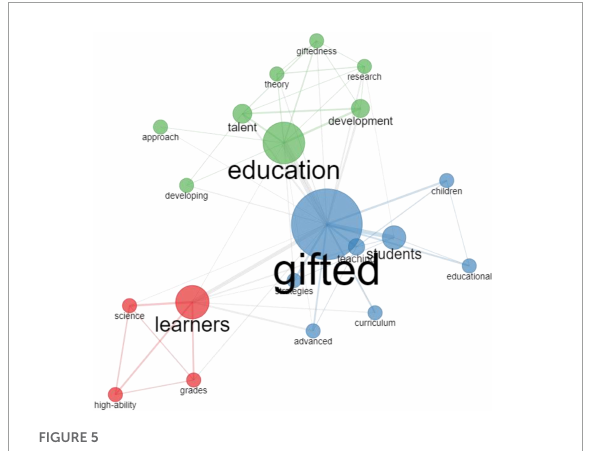
FIGURE5 Co-occurrence map of words in titles.